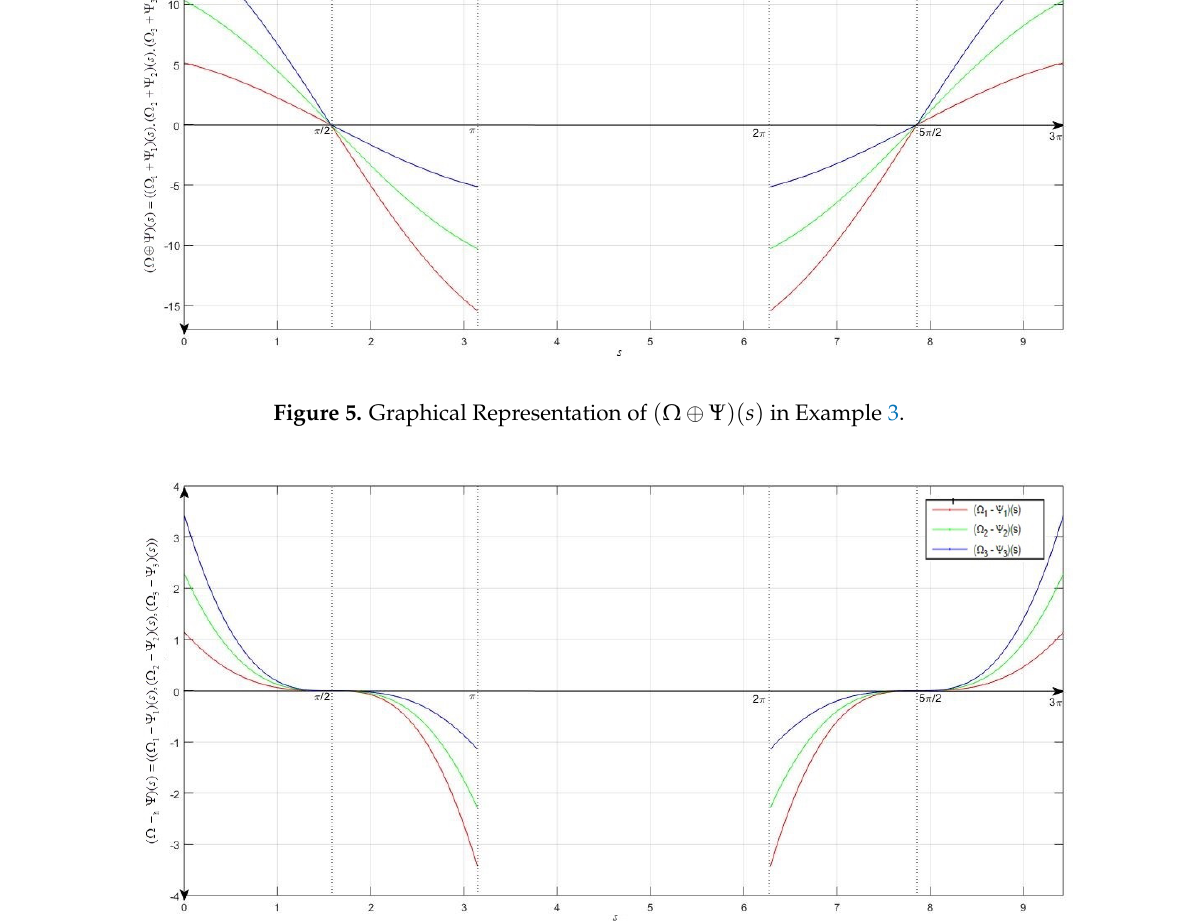
Figure 6. Graphical Representation of ( Ω (cid:9) h Ψ )( s ) in Example